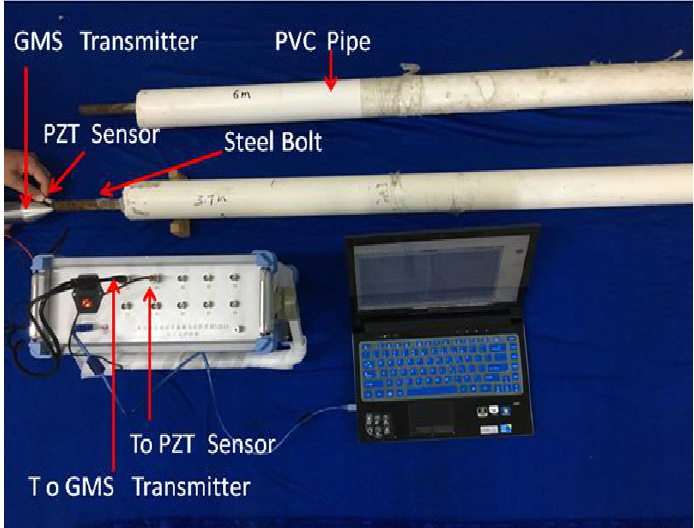
Figure 10. Laboratory setup for the NDE of rock bolts.